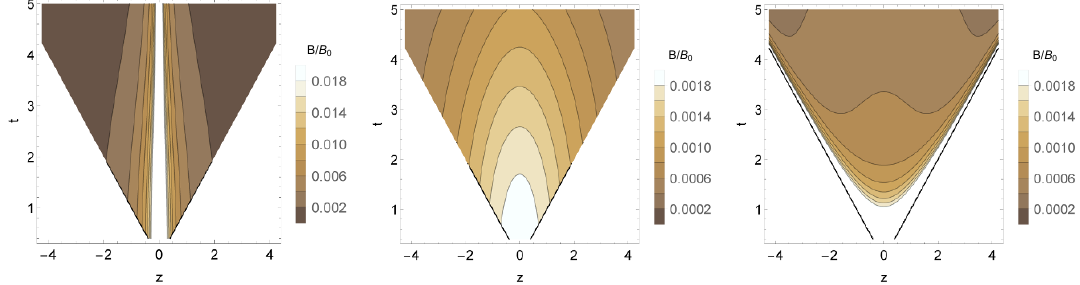
Figure 8 . (color online). The magnitude of the magnetic (cid:12)eld in the longitudinal ( t (cid:0) z ) plane from current free solution, i.e. eq. (4.1) using parameters (cid:12)xed in (6.7) for ! 1 = 0 : 5 ; ! 2 = 0 : 05 at (a) y = 0, (b) y = L= 2, and (c) y = L . At y = L the earliest iso-magnetic lines resemble the Bjorken